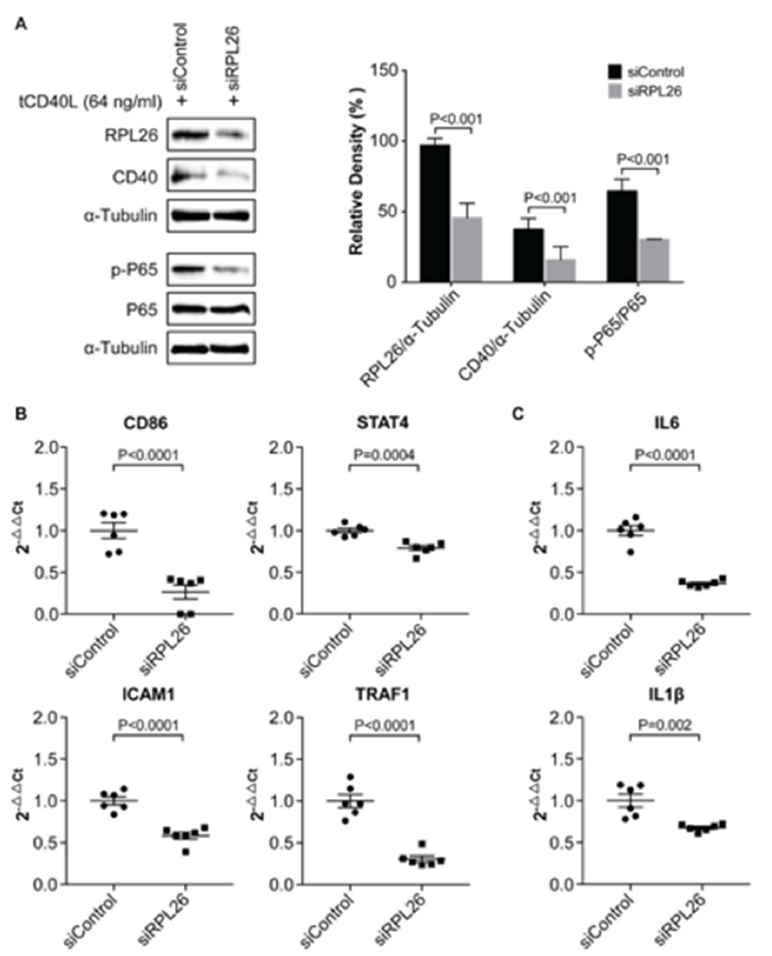
Figure 4. Regulation of disease-associated risk genes STAT4, TRAF1, ICAM1 , and CD86 by RPL26 via disease-associated TRN linked by CD40-induced NF- κ B signal pathway. ( A ) Western blots showing inactivation of NF- κ B p65 by dephosphorylation upon CD40L activation in the RPL26 siRNA knockdown FLS. Statistical analysis based on the relative density is shown. ( B ) real time PCR showing downregulation of four disease-associated risk genes STAT4, TRAF1, ICAM1 , and CD86 as the direct targets of NF- κ B p65, ( C ) real time PCR showing downregulation of IL6 and IL1 β as the direct targets of NF- κ B p65. si: